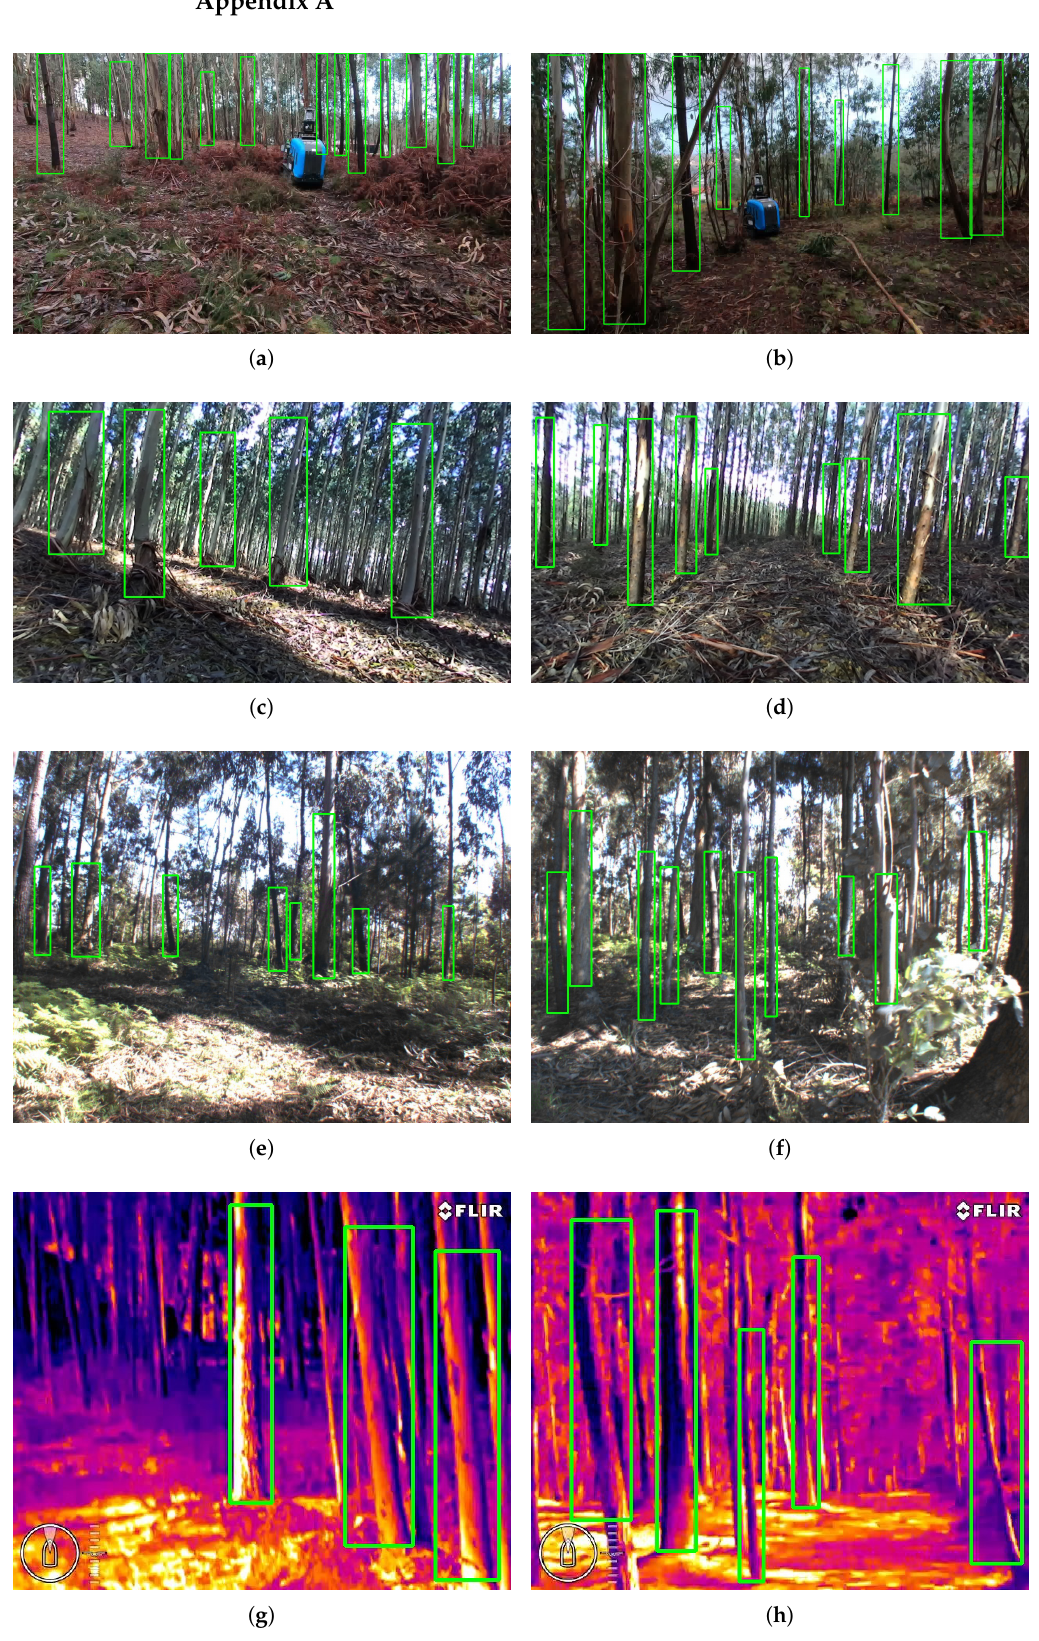
Figure A1. Examples of images with manual annotations: ( a , b ) are visible images from Lobão, ( c , d ) are visible images from Valongo, ( e , f ) are visible images from Vila do Conde, and ( g , h ) are thermal images from